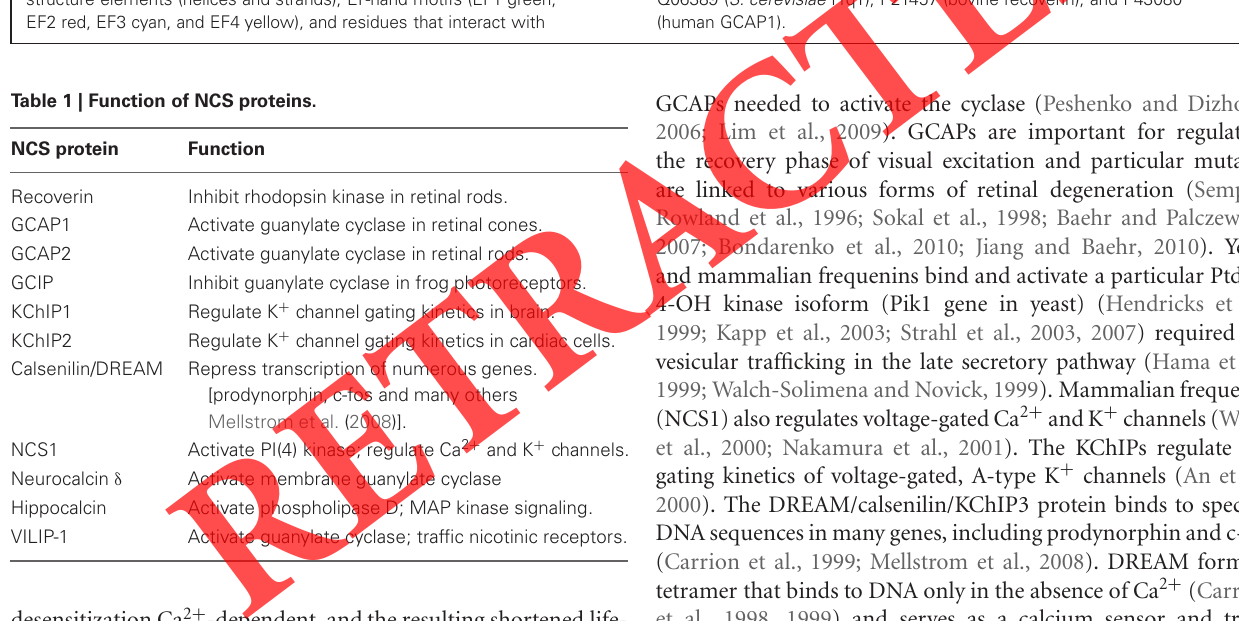
the myristoyl group (highlighted magenta) are indicated. Swiss Protein Database accession numbers are Q09711 ( S. pombe Ncs1),